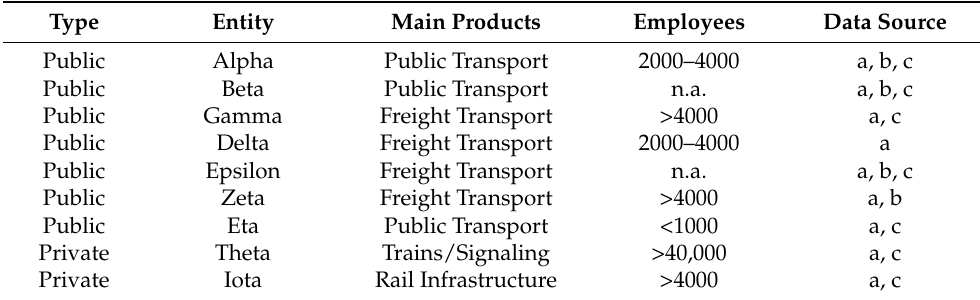
Table 1. Overview of respondents’ backgrounds and list of data